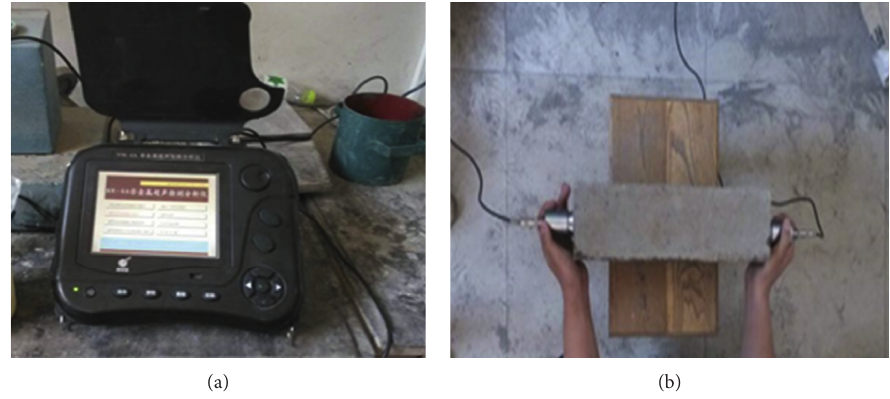
Figure 1: NM-4A nonmetal ultrasonic detection analyzer.